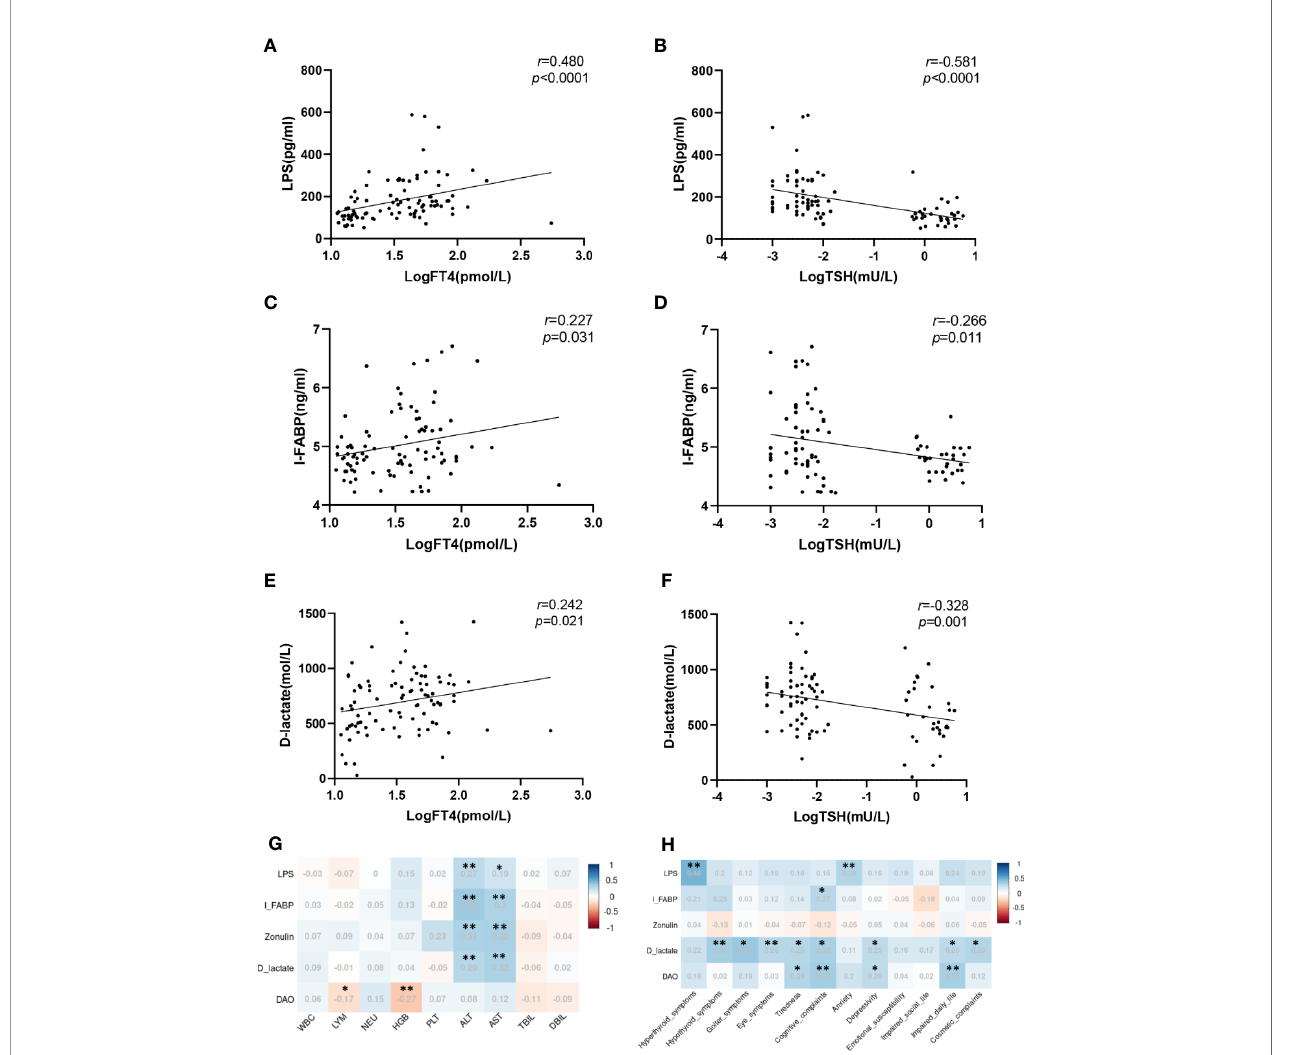
FIGURE 2 | Leaky gut biomarkers associated with thyroid function, laboratory parameters, and quality of life in patients with GD. (A) Correlation of serum LPS with log-transformed FT4; (B) Correlation of serum LPS with log-transformed TSH; (C) Correlation of serum I-FABP with log-transformed FT4; (D) Correlation of serum I- FABP with log-transformed TSH; (E) Correlation of serum D-lactate with log-transformed FT4; (F) Correlation of serum D-lactate with log-transformed TSH; (G) Correlation of circulating gut barrier biomarkers with laboratory parameters; (H) Correlation of circulating gut barrier biomarkers with quality of life; * p < 0.05; ** p < 0.01; FT4, free thyroxine; TSH, thyroid stimulating